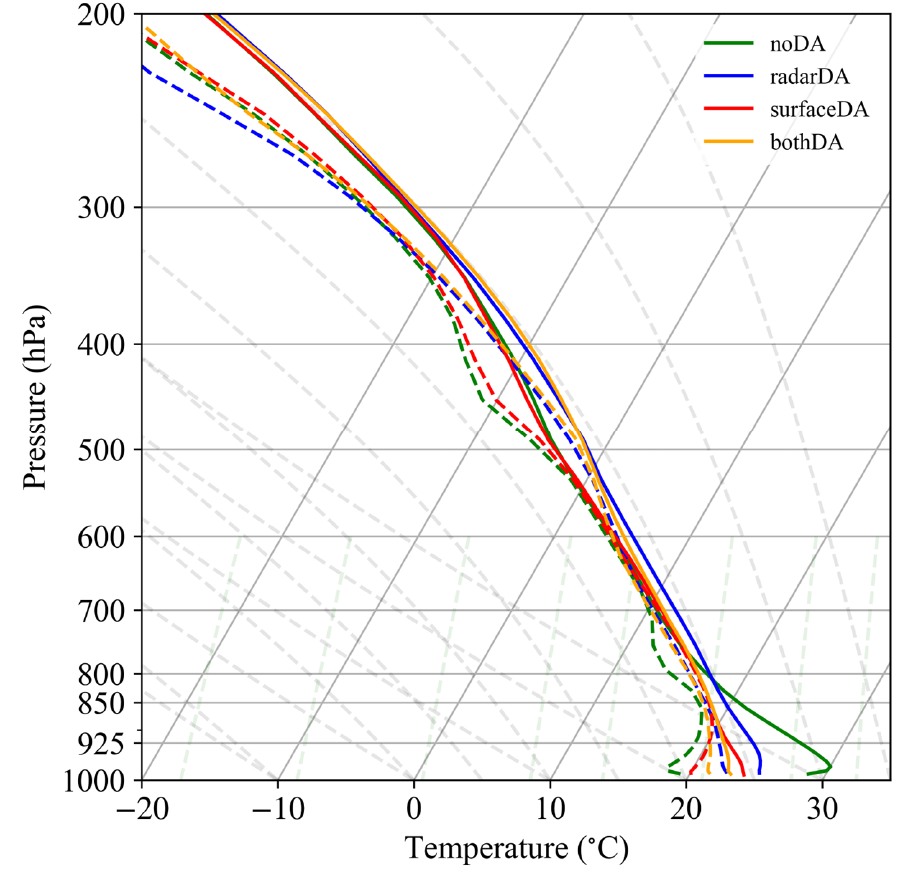
Figure 11. The area ‐ averaged soundings taken in the initiation area of the squall line (denoted by the black box in Figure 9) at 1530 UTC 11 July 2014 for noDA (green line), radarDA (blue line), surfaceDA (red line) and bothDA (orange line) experiments. The dotted lines represent the dew point temperature, and the realizations describe the temperature.